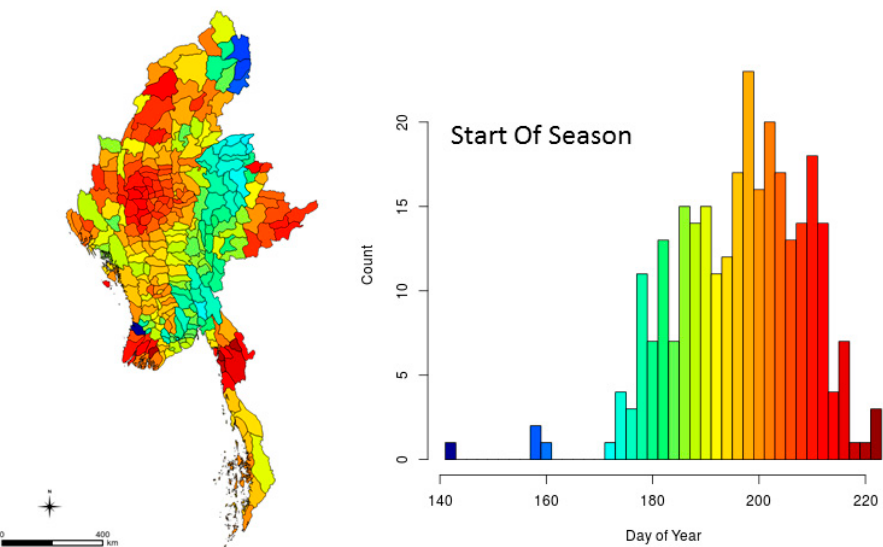
Figure 13. Rice crop start-of-season distribution across administrative units highlighting spatial variability and regional trends in crop calendar.